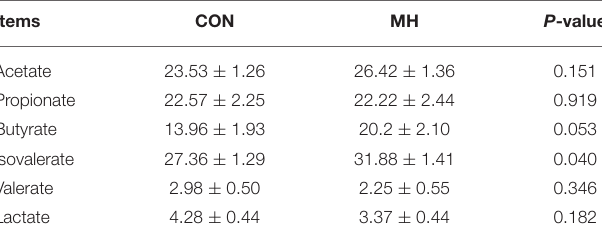
TABLE 7 | Effects of moderate-high dose LM1 on fecal SCFA levels of growing pigs a ( µ mol/g dry